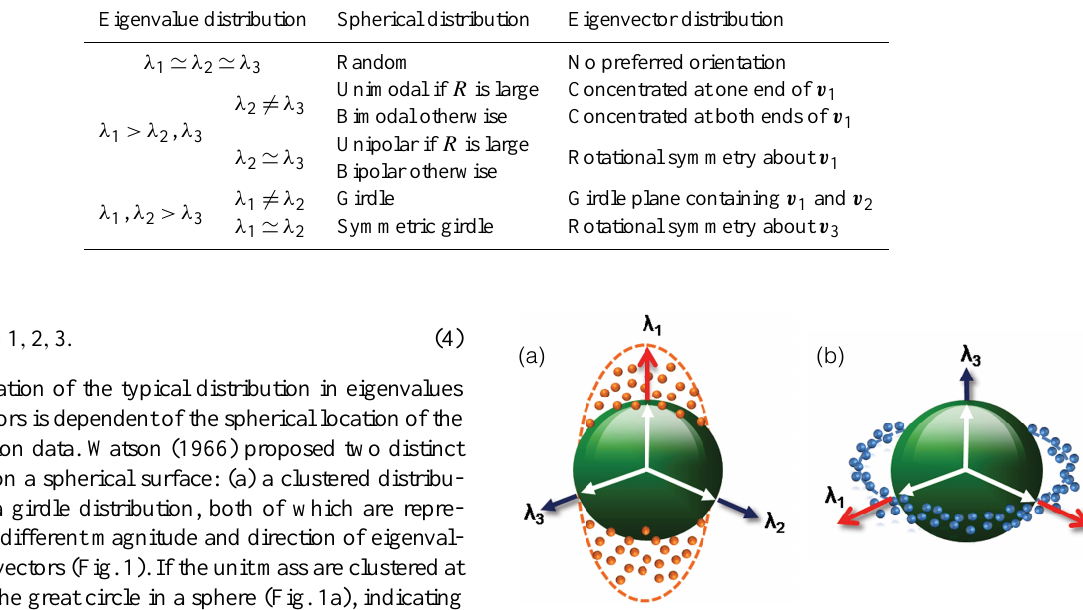
Figure 1. Distribution of axial orientation data on a spherical sur- face: (a) a clustered distribution and (b) a girdle distribution. In a clustered distribution, the axial orientation data have one large eigenvalue ( λ 1 ) and two small eigenvalues ( λ 2 , λ 3 ). In contrast to this, the axial orientation data have one small eigenvalue ( λ 3 ) and two large eigenvalues ( λ 1 , λ 2 ) in a girdle